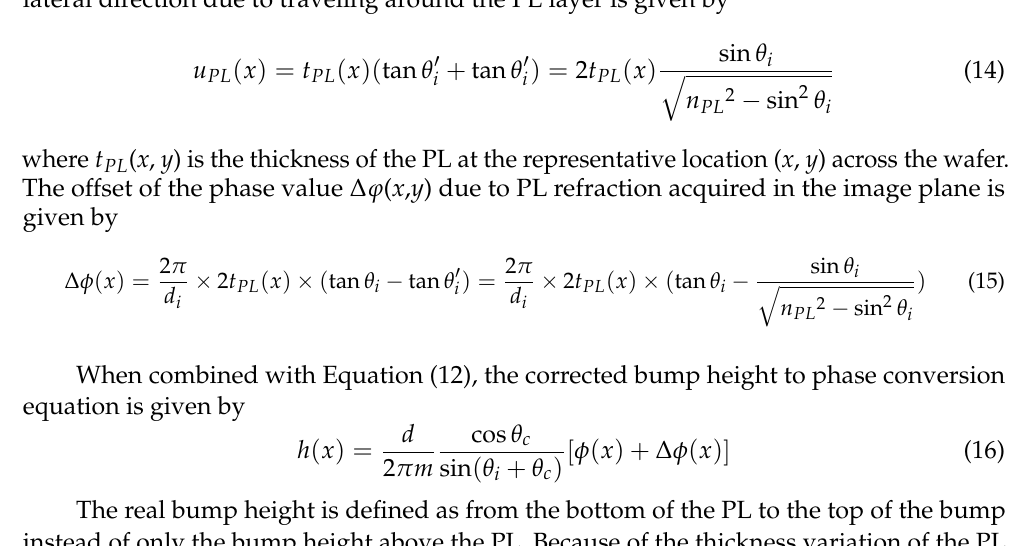
Table 1. Calibrated step heights of the reference standard.